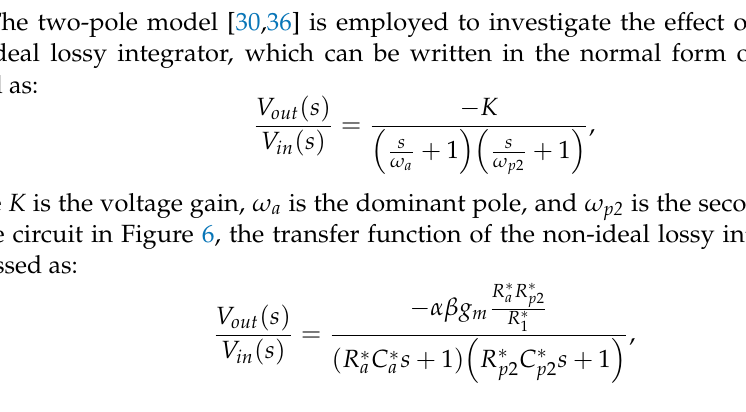
Figure 6. Model of non-ideal lossy integrator with parasitic elements.